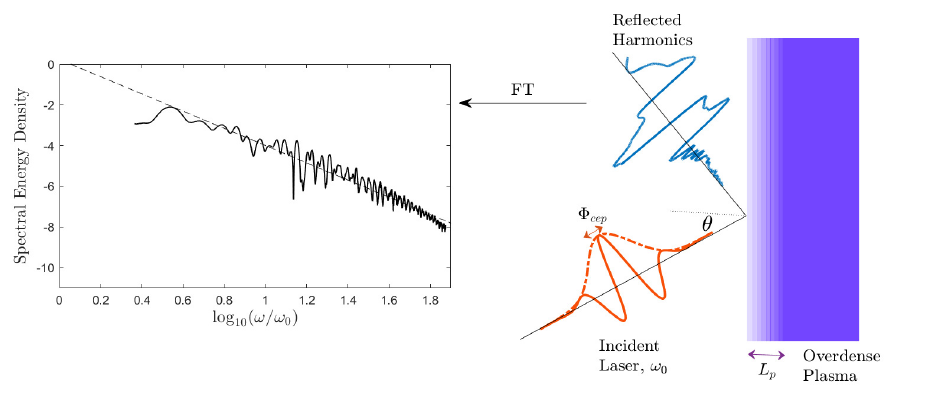
Figure 1. A schematic diagram showing the simulated scenario. A laser pulse angularly incident on a solid plasma target with a pre-plasma length. The reflected spectrum contains harmonics of the laser’s initial frequency, and the intensity of these harmonics decays with increasing harmonic